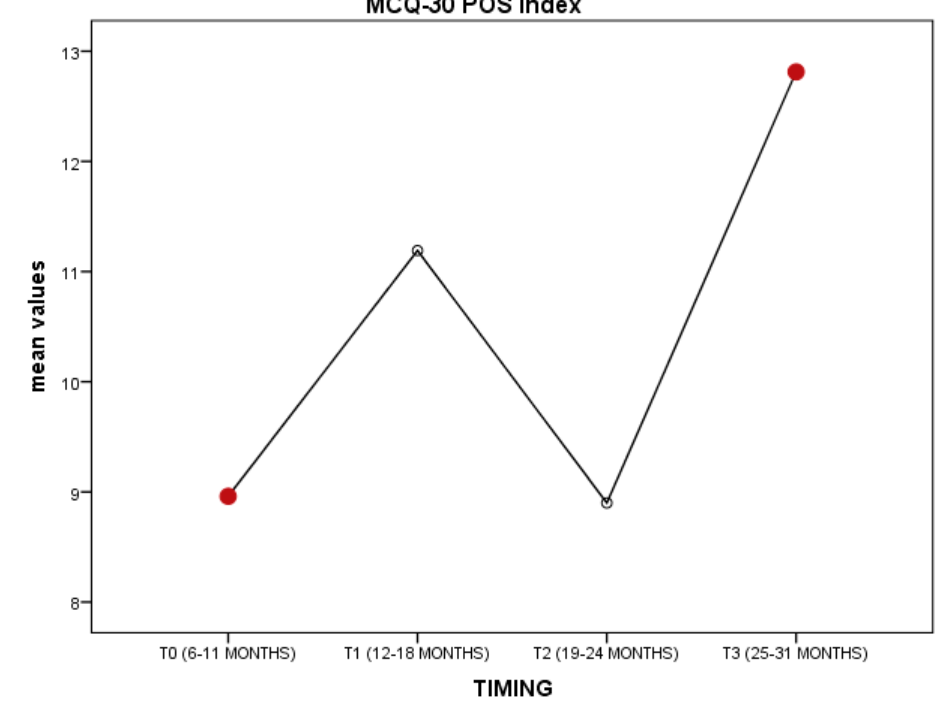
Figure 1. Representation of MCQ-30 POS index over time.